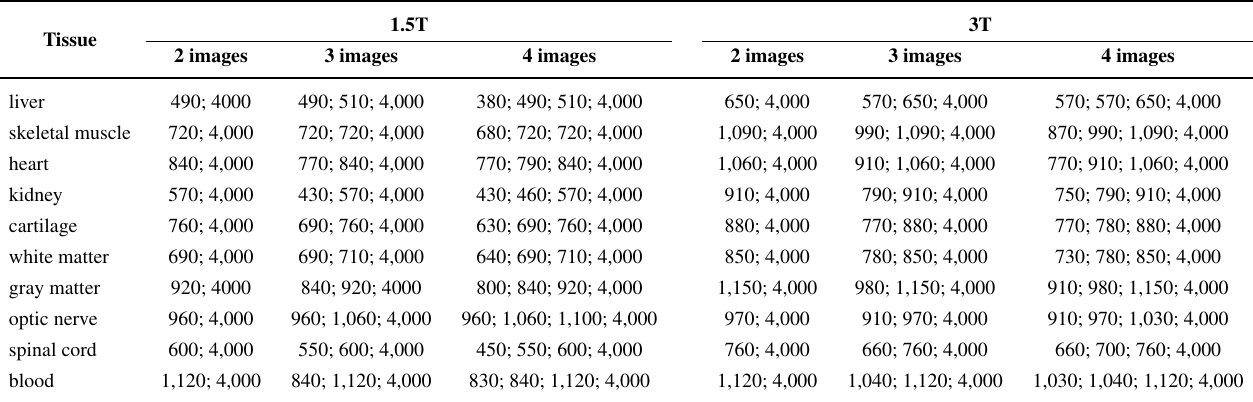
Table 1. Optimal repetition times, T numbers of acquisitions at 1.5 T and 3